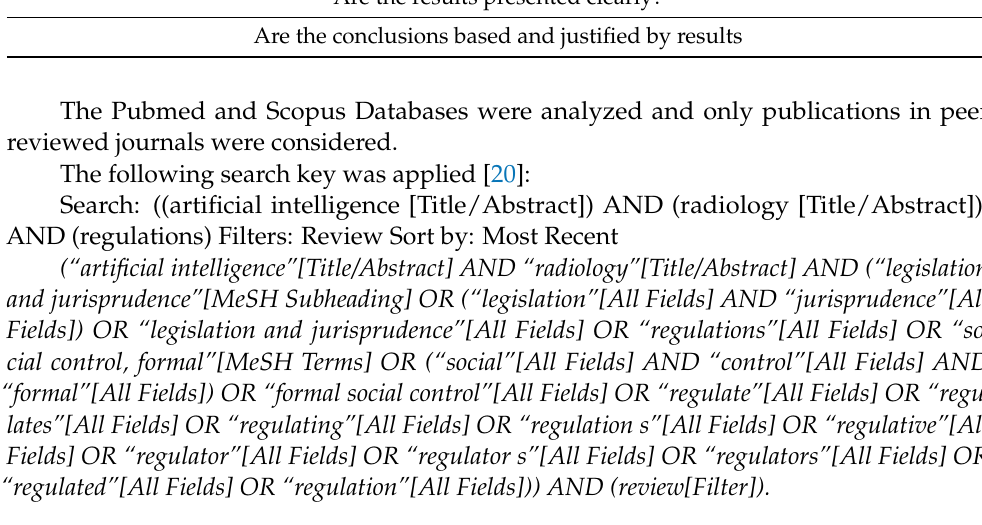
Table 1. Parameters used for the qualification (standardized table). PARAMETER ASSESSED Is the rationale for the review in the introduction clear? Is the design of the review appropriate? Are the methods described clearly? Are the results presented clearly? Are the conclusions based and justified by